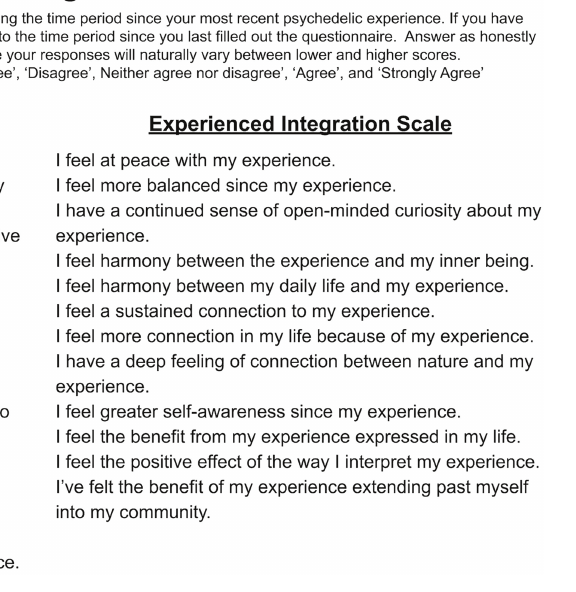
FIGURE 1 | Psychedelic Integration Scales final